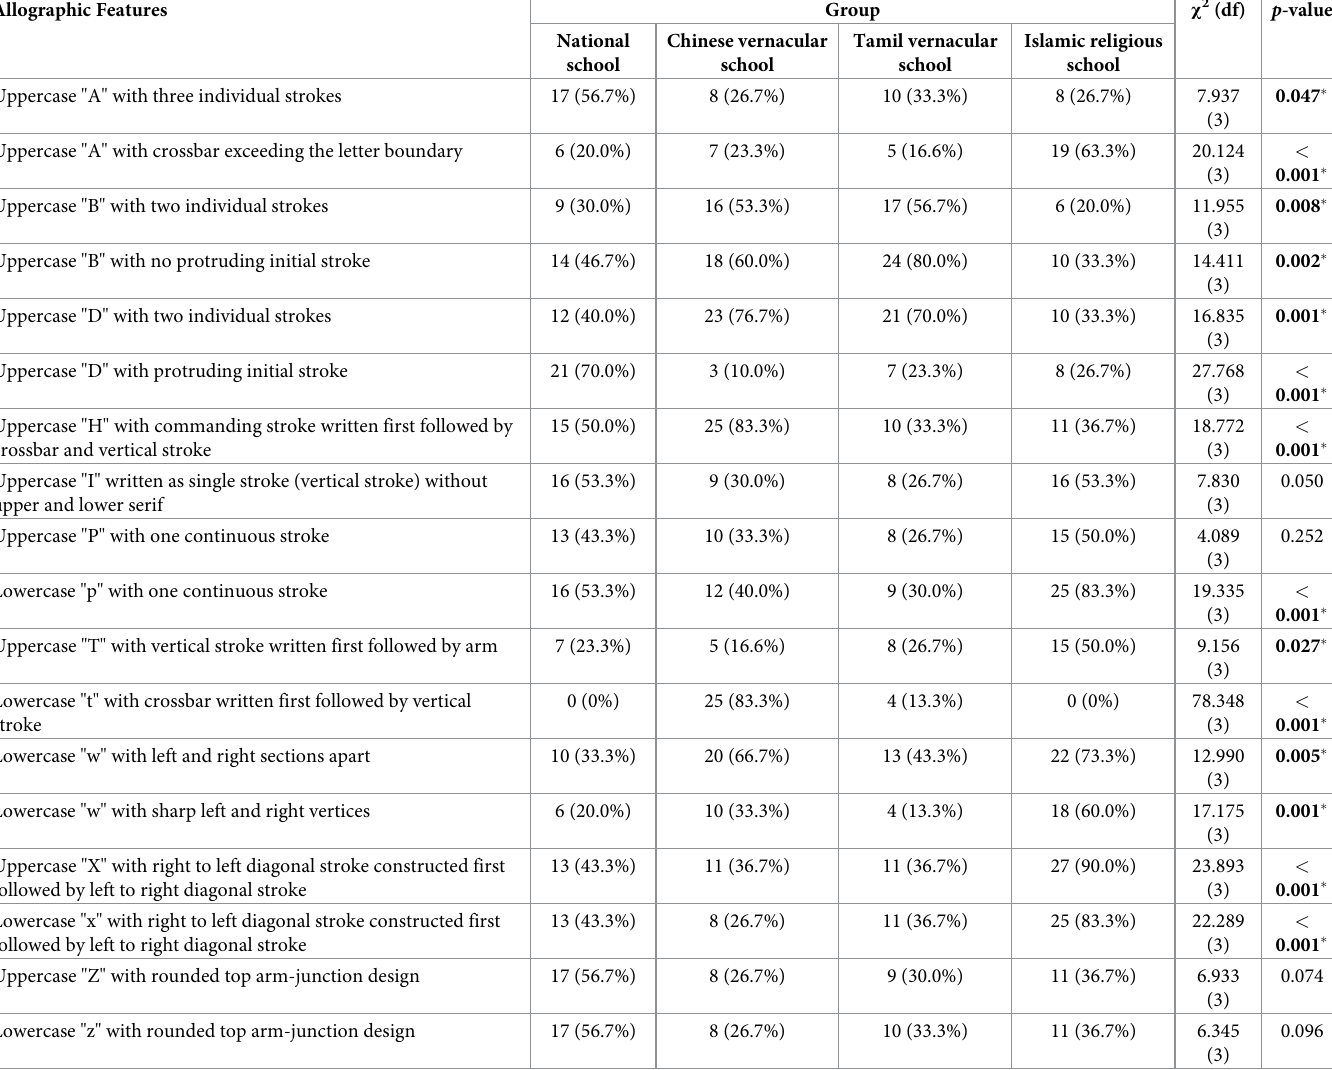
Table 2. Association of allographic features with educational backgrounds using Pearson’s Chi Square